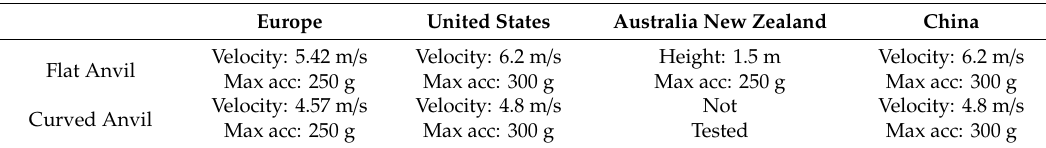
Table 1. Helmet testing thresholds imposed by di ff erent testing standards.